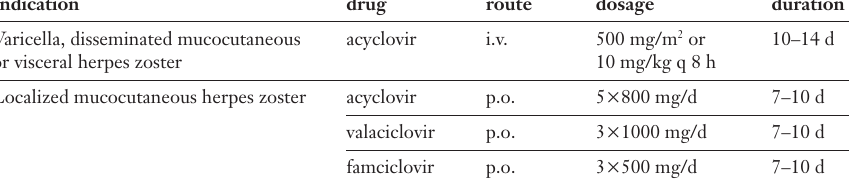
Recommendations for the treatment of VZV disease in immunocompromised cancer